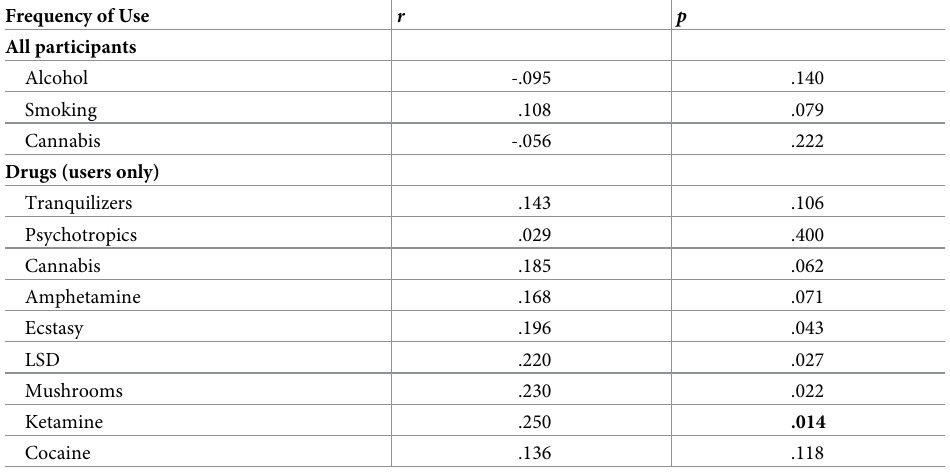
Table 2. Pearson Correlation Coefficients (one-tailed) for frequency of use and sense of agency.